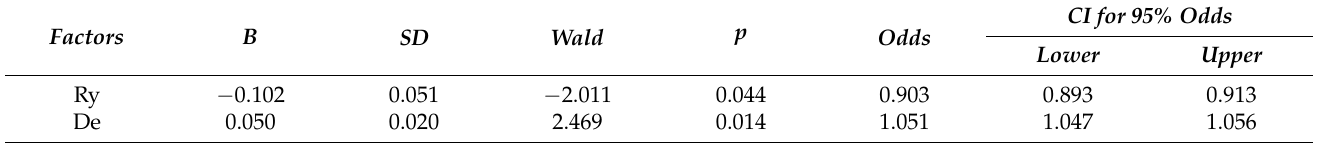
Table 6. Logit model for Personal Accomplishment (PA) ˆL s ( Ry,De ) = ˆB 0 + ˆB Ry Ry + ˆB De De; s = 1,2.